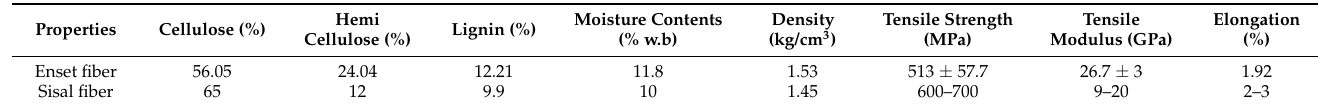
Table 1. Chemical composition and mechanical properties of enset and sisal fibers (Data reproduced